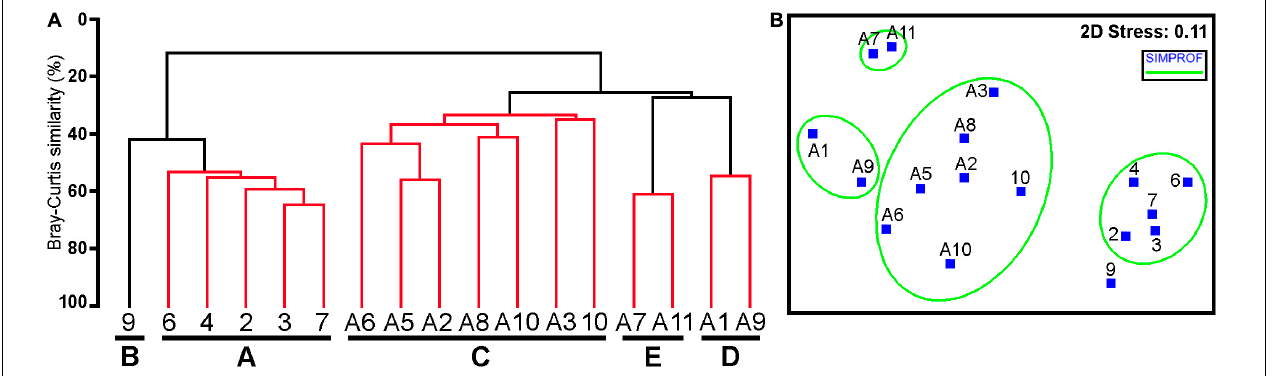
FIGURE 3 | Cluster (A) and MDS (B) based on quantitative similarities (fourth root transformed data) among the bivalve and polychaete assemblages of box-corer samples taken at 17 stations by the SokhoBio and KuramBio II expeditions. (Red lines indicate the samples that cannot be significantly differentiated by SIMPROF).